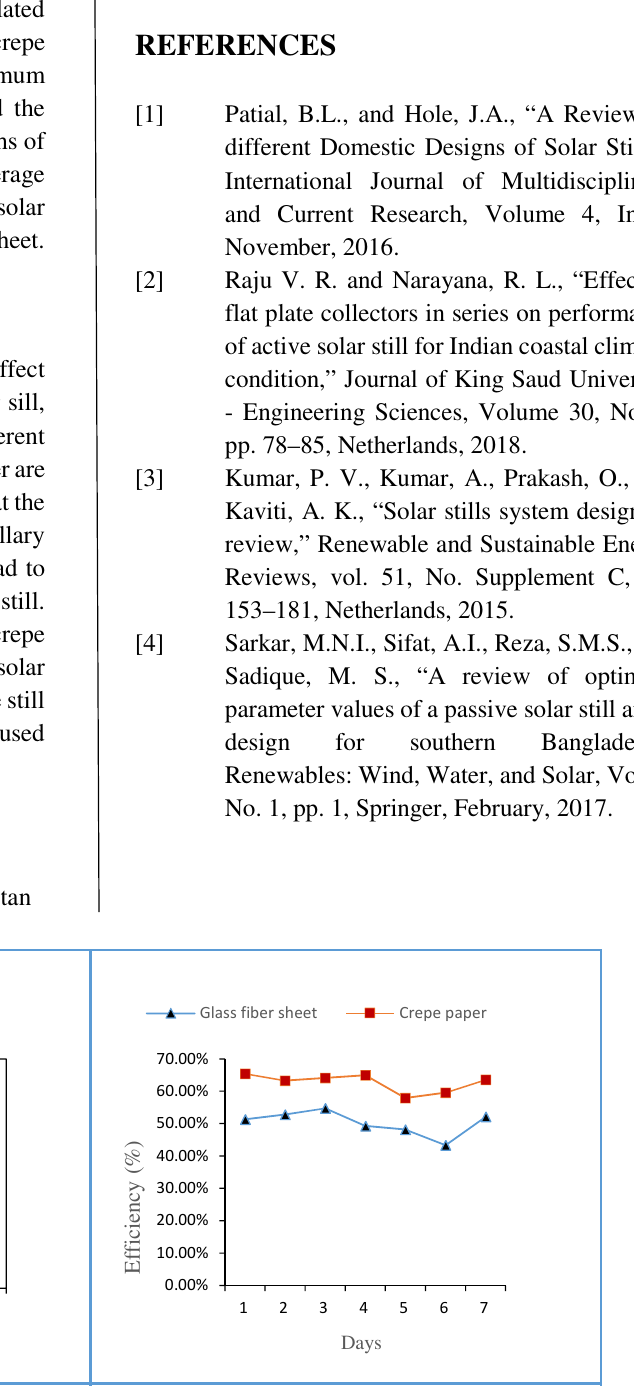
FIG. 11. EFFICIENCIES OF THE STILL WITH GFS AND CREPE PAPER FOR JUNE